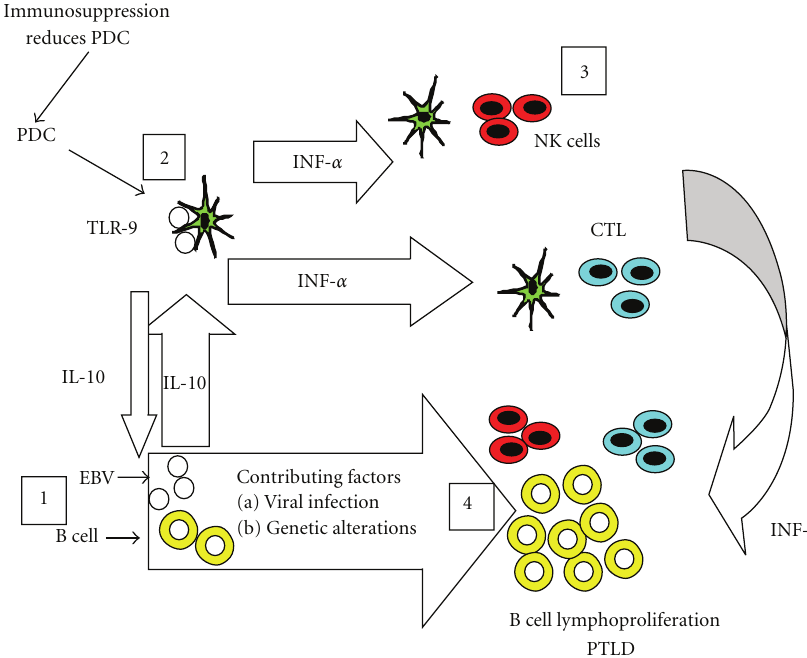
Figure 2: A proposed model of pathogenesis of EBV infection in the development of PTLDs in sold organ transplant recipients. CTL: cytotoxic T lymphocytes, IL-10: interleukin-10, INF- α : Interferon- α , NK cells: natural killer cells, PDC: plasmacytoid dendritic cells, TLR-9: toll-like